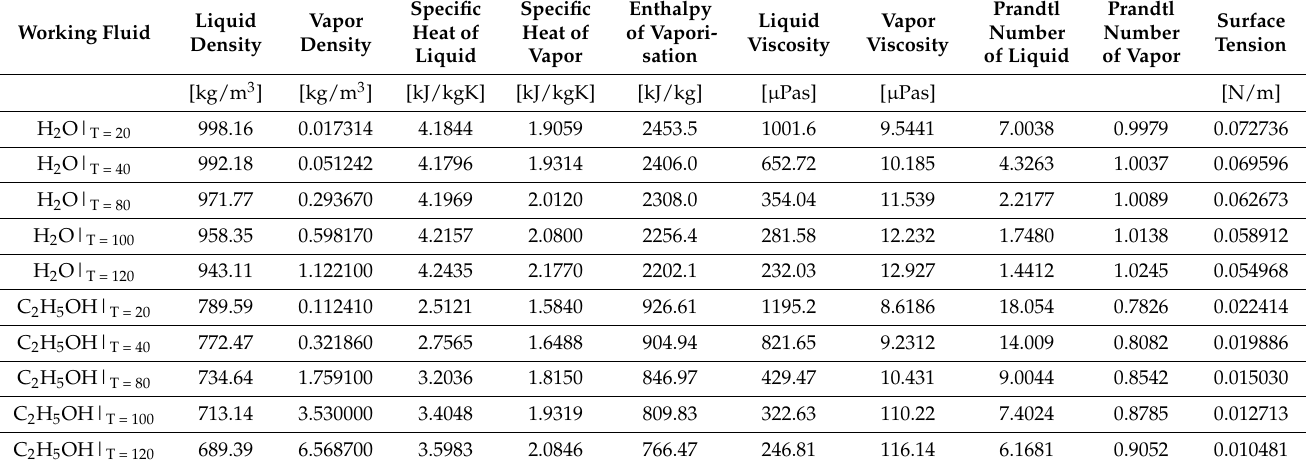
Table 2. Comparison of physicochemical parameters of water and ethanol versus